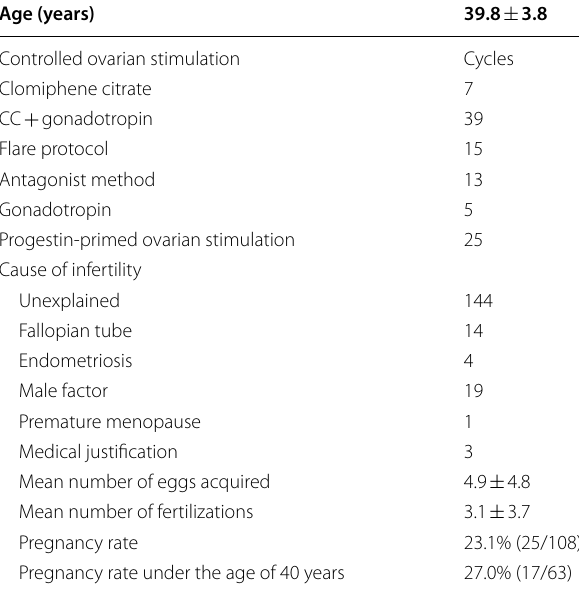
Table 1 Characteristics of study shows number of controlled ovarian stimulation, number of cause of infertility, mean number of eggs acquired, mean number of fertilizations, and